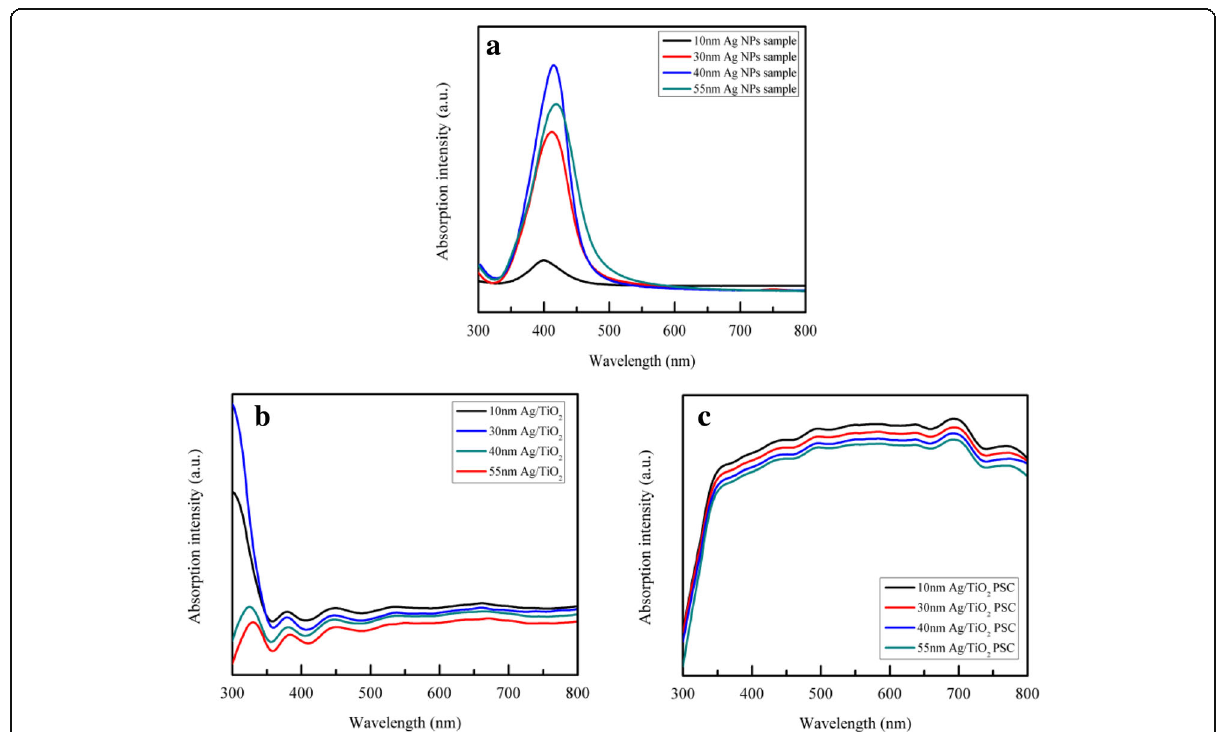
Fig. 4 UV-vis absorption spectra of the a different sizes of Ag NP sample, b Ag/TiO 2 samples with various sizes of Ag NPs, and c Ag/TiO 2 PSC device samples with various sizes of Ag